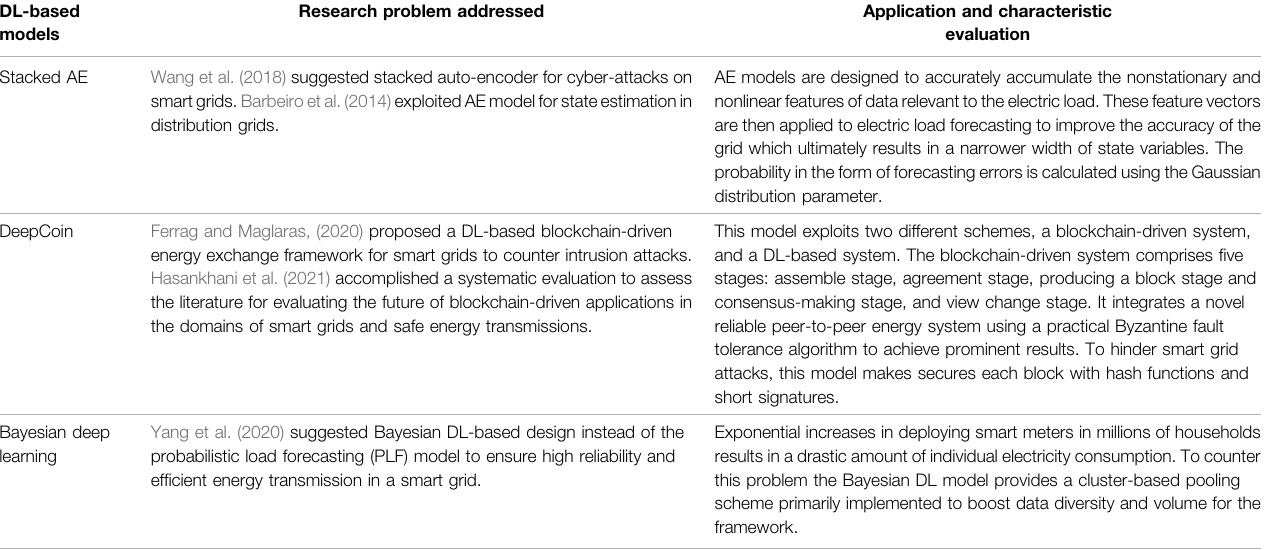
TABLE 1 | Different DL-based model used in smart grid